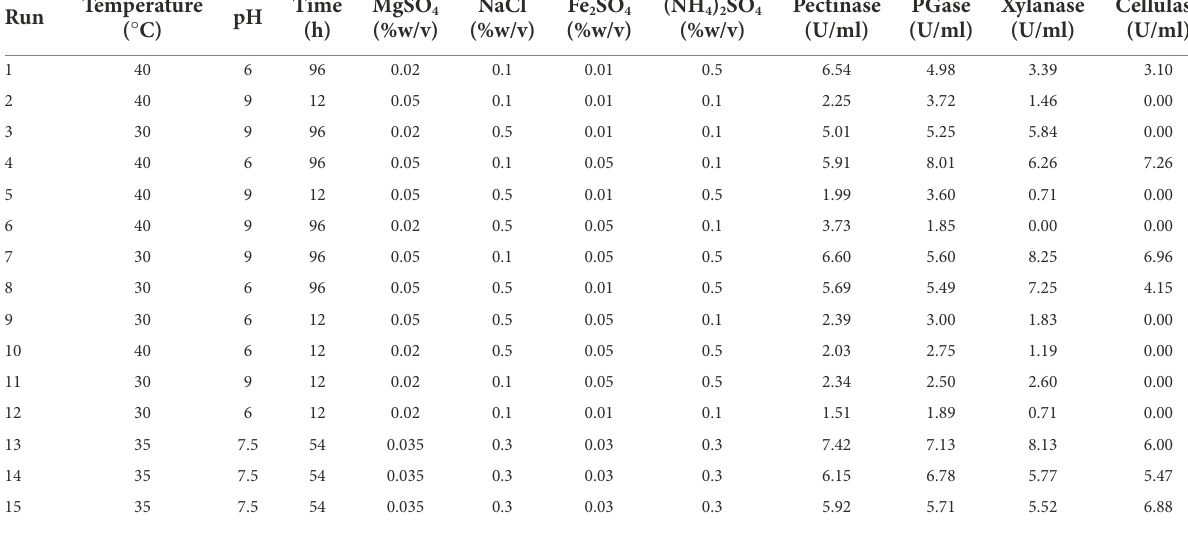
TABLE 1 Experimental design and enzymes activities (U/mL) using Plackett–Burman factorial design. Temperature Run ( ° C)